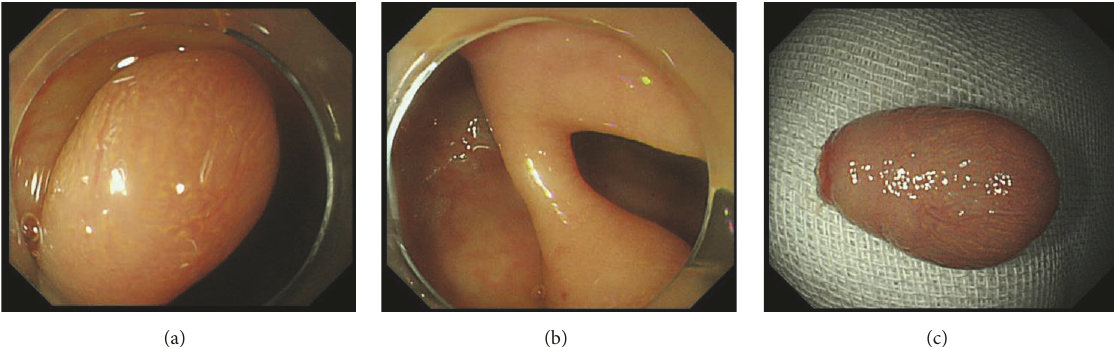
Figure 1: Endoscopic images of Case 1. A pedunculated polyp covered with intact mucosa is observed (a, b). Resected polyp is 10mm in diameter and 14 mm in length (c).